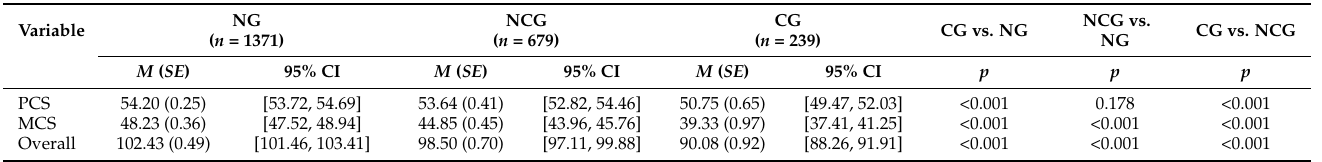
Table 4. Means, standard error, and 95% confidence intervals for the health-related quality of life according to grazing